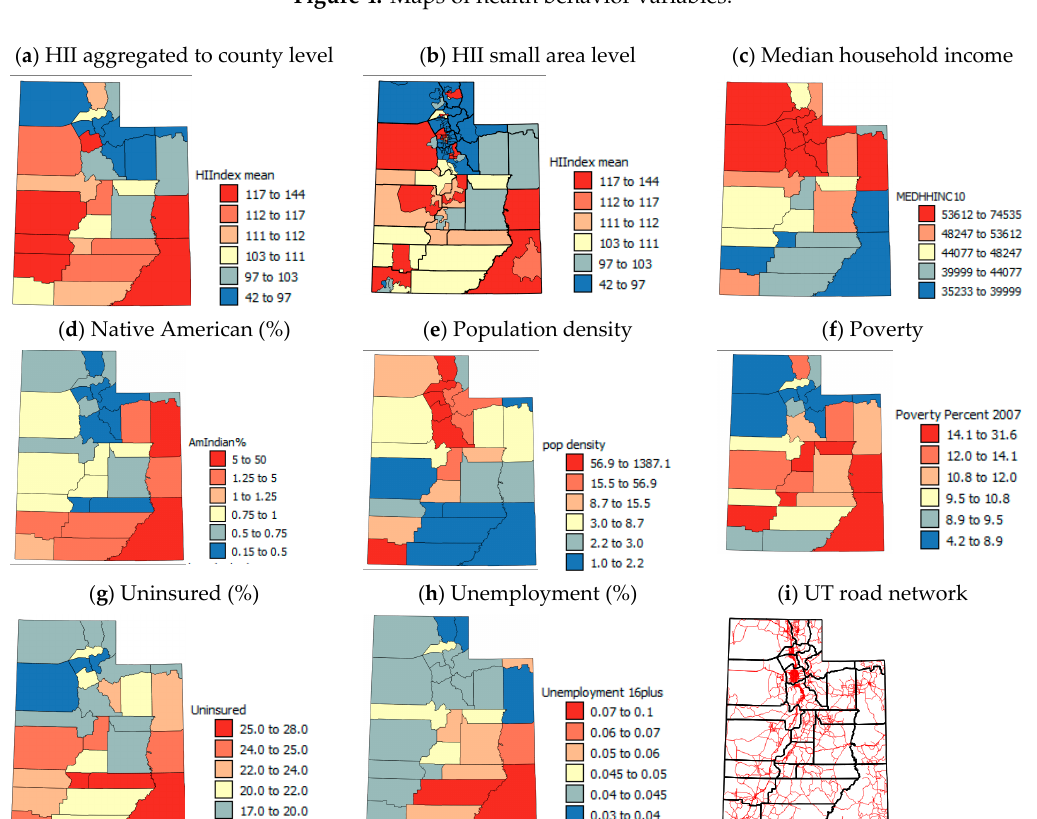
Figure 4. Maps of health behavior variables.